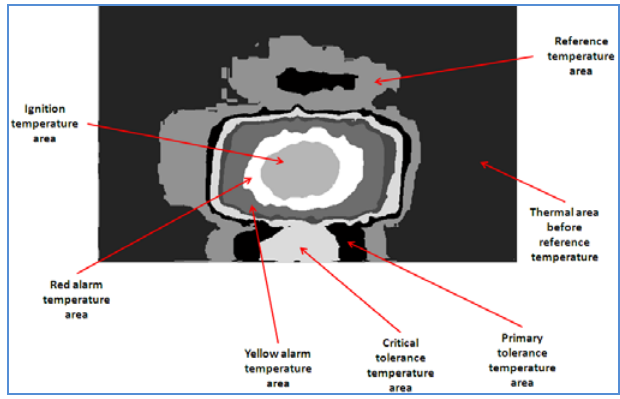
Figure 9. Segmentation of thermal image into respective temperature affected region